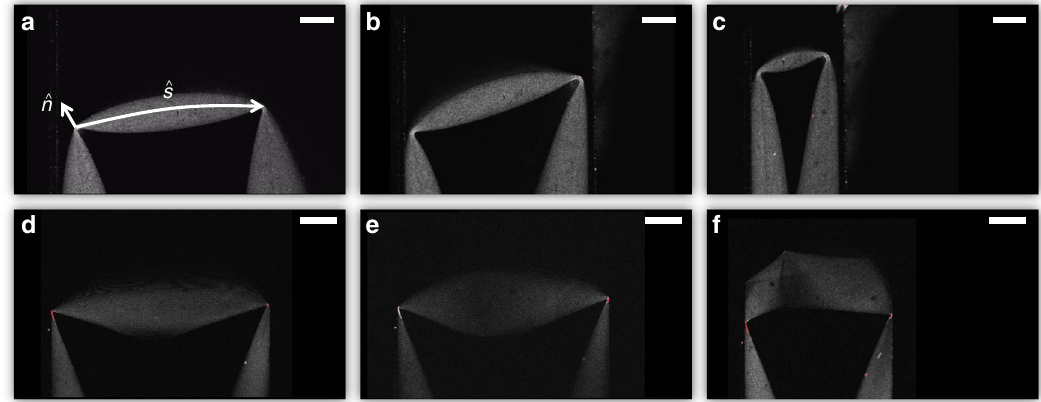
Fig. 5 Confocal microscopy of the compression of a stretching ridge. a Geometry of a 58.5- μ m-thick polydimethylsiloxane ridge con fi ned to a X = 11.3 mm gap. Scale bar represents 2 mm. b , c show the effects of additional compression where X = 6.3 mm and X = 2.8 mm, respectively. d – f show similar compression of a 9.3- μ m polycarbonate fi lm at X = 11.7 mm, X = 11.0 mm and X = 7.7 mm, respectively. In this case, the ridge buckles, forming two new d- cones as it is compressed. Again the scale bar represents 2